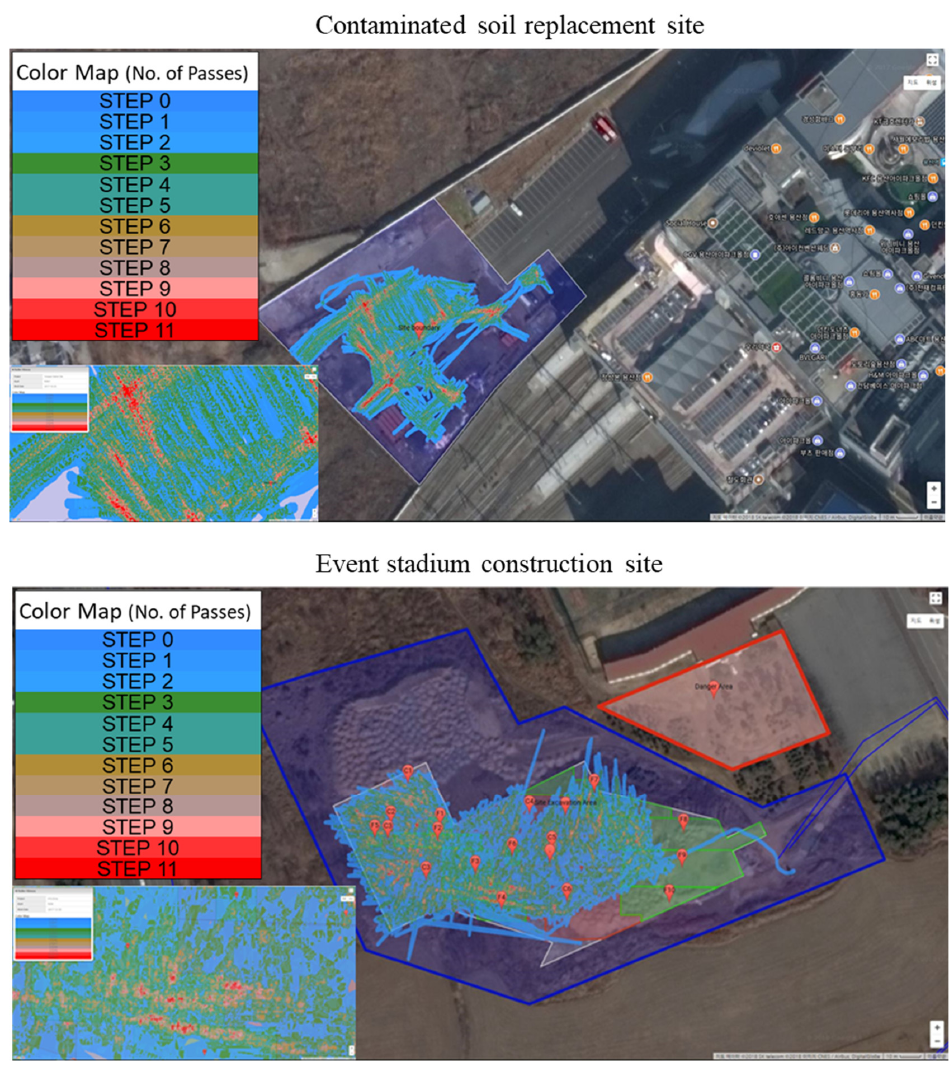
Figure 10. Screenshot of the system software visualizing the position and number of passes.